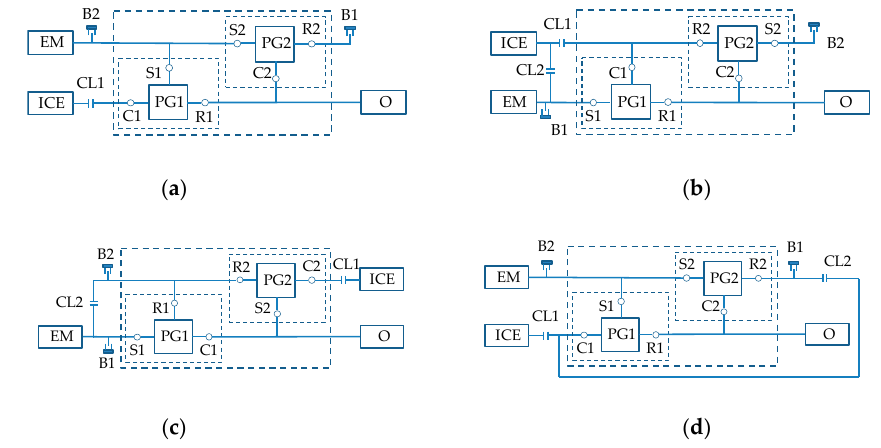
Figure 13. Type-c typical architecture developed by ( a ) Tsai; ( b ) Zhu; ( c ) Chachra; ( d ) Tsai.